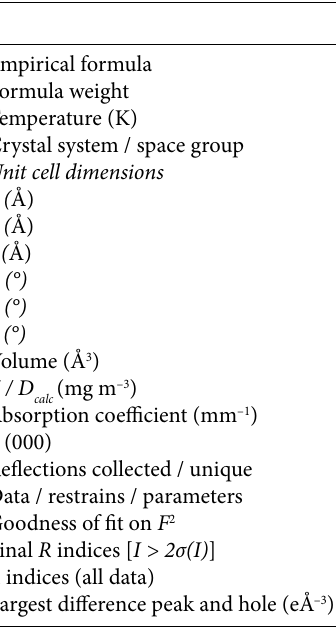
Table 1 . Crystal data and structure refinement parameters for the compounds 1 and 2